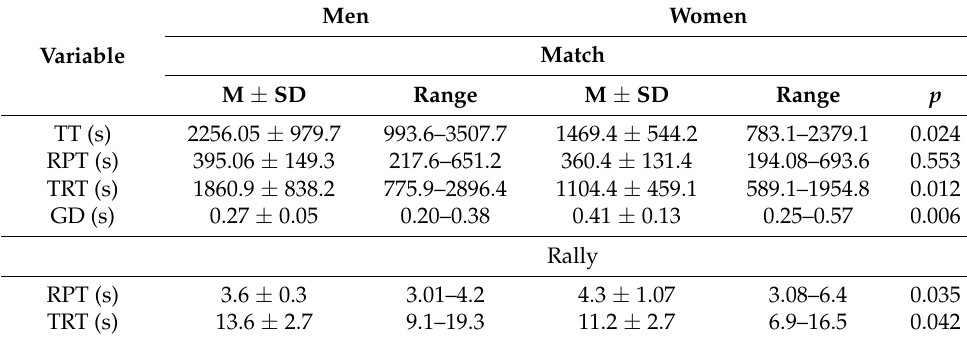
Table 2. Game temporal structure